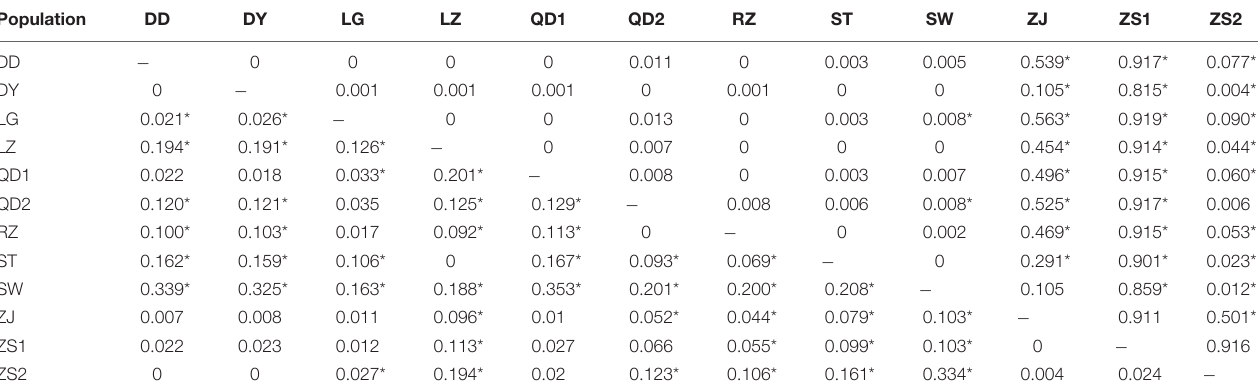
TABLE 3 | Pairwise F ST values of 12 populations of Konosirus punctatus for COI (below) and Cytb (above).